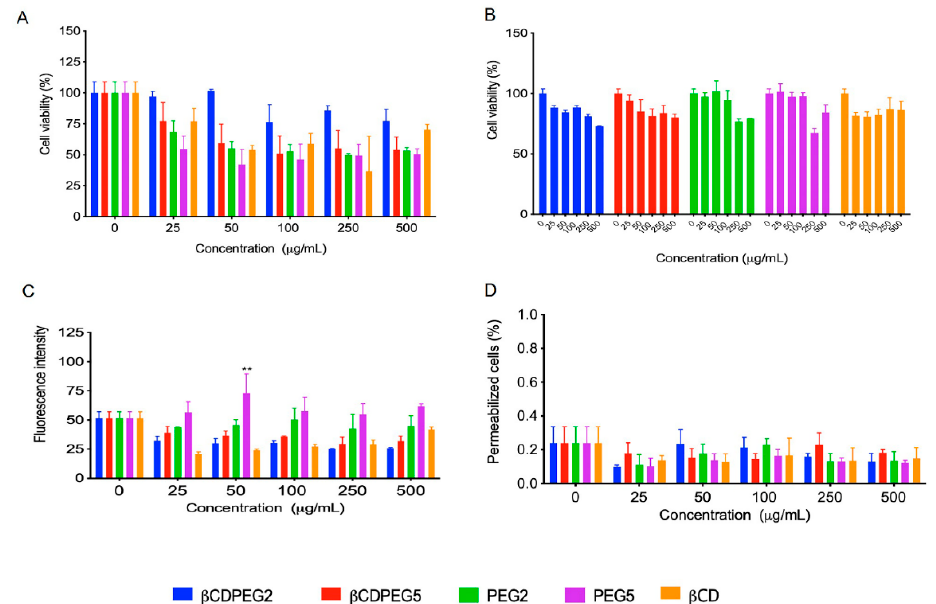
Figure 3. Effect of β CDPEGs, β CD, and PEGs on MC3T3-E1 osteoblast ( A ) cell viability; ( B ) cell viability recovery assay; ( C ) ROS overproduction; and ( D ) cell membrane permeability. All results are expressed as the mean ± SD ( n = 3), ** p < 0.01 using two-way ANOVA with Dunnett’s multiple comparison tests.